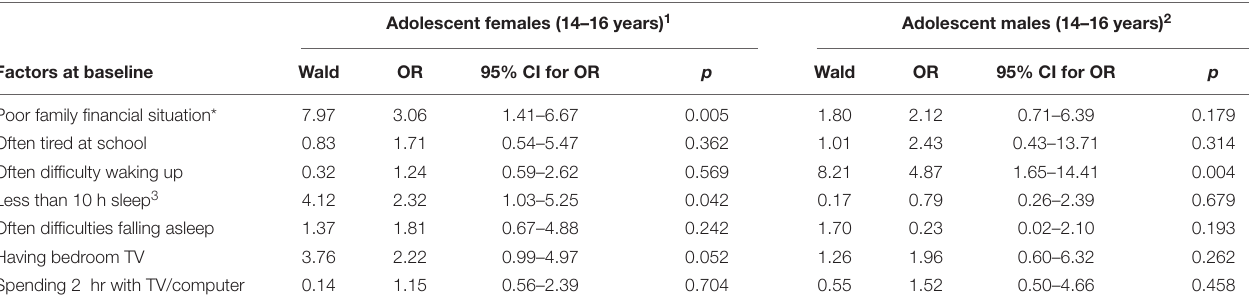
TABLE 2 | Multiple logistic regression analysis of the associations between insomnia (MISS-R ≥ 6) at follow-up and factors at baseline, n =